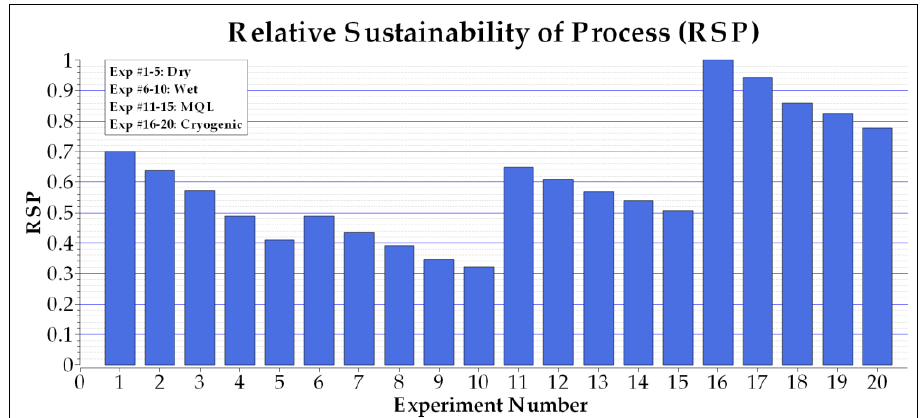
Figure 4. RSP of the alternatives in Sivaiah and Chakradhar [24].